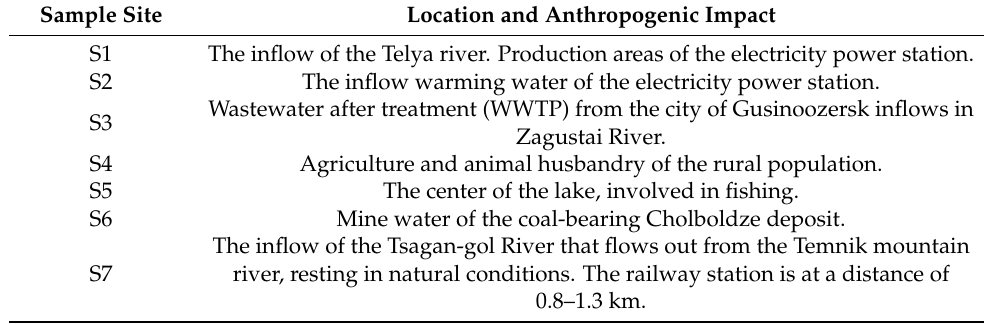
Table 1. Sampling site and their location within Lake